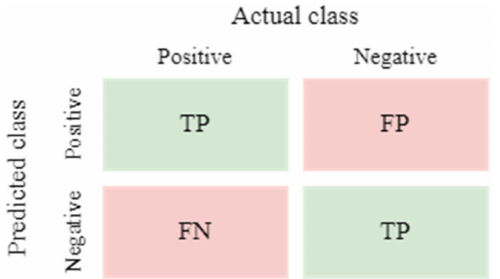
Figure 3. Confusion matrix.